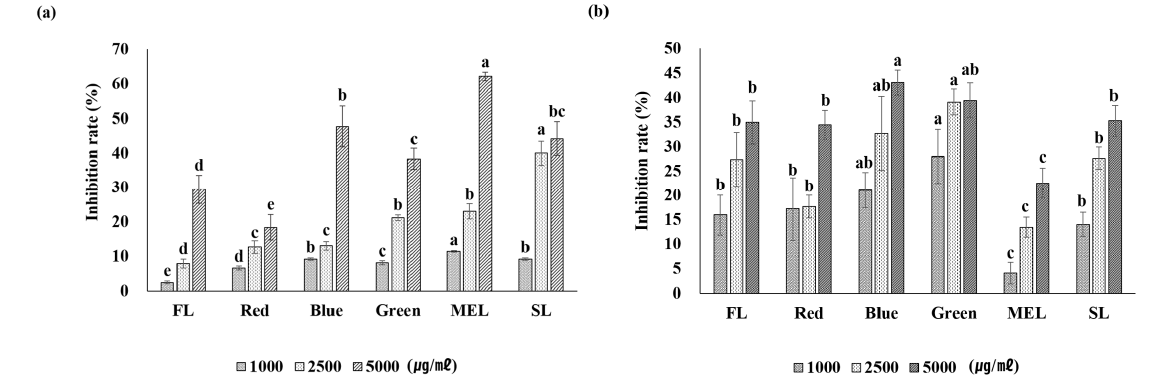
Figure 5. The inhibition rate of tyrosinase of aerial ( a ) and underground ( b ) parts from extracts of Dachul under different light